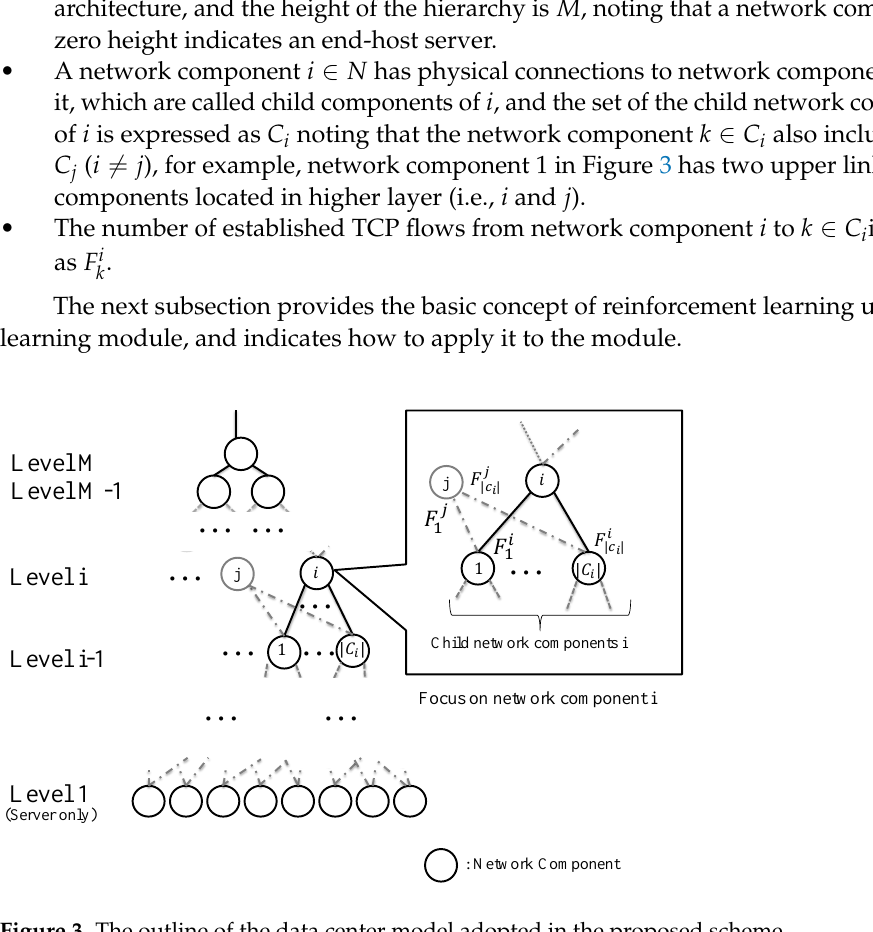
Figure 3. The outline of the data center model adopted in the proposed